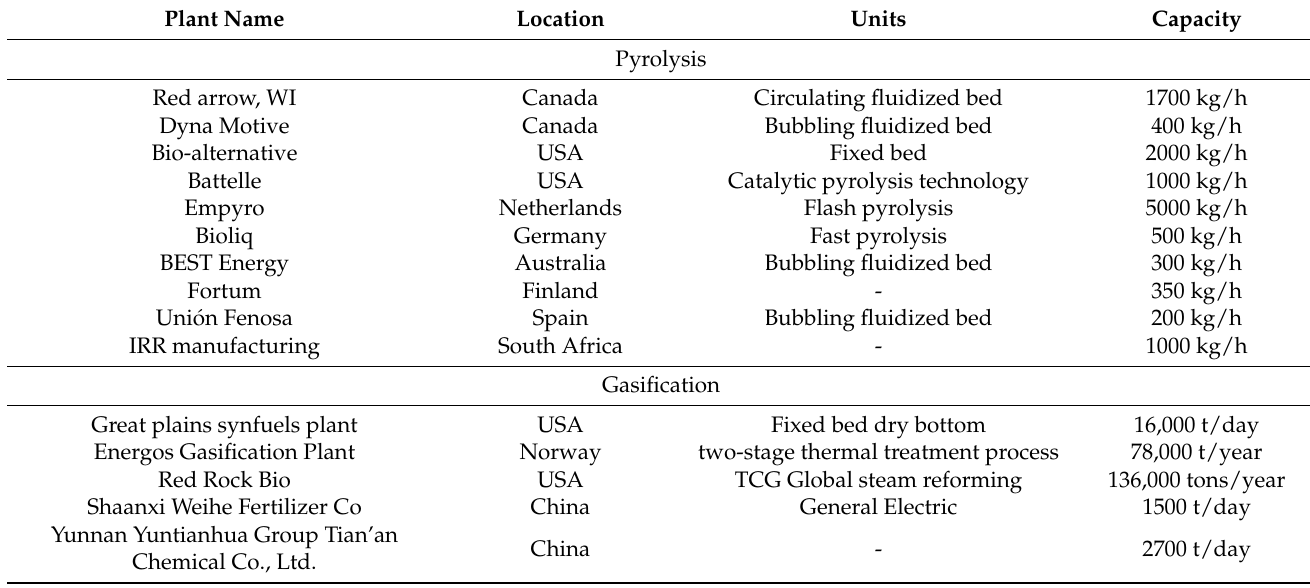
Table 3. Worldwide current pyrolysis and gasification operating